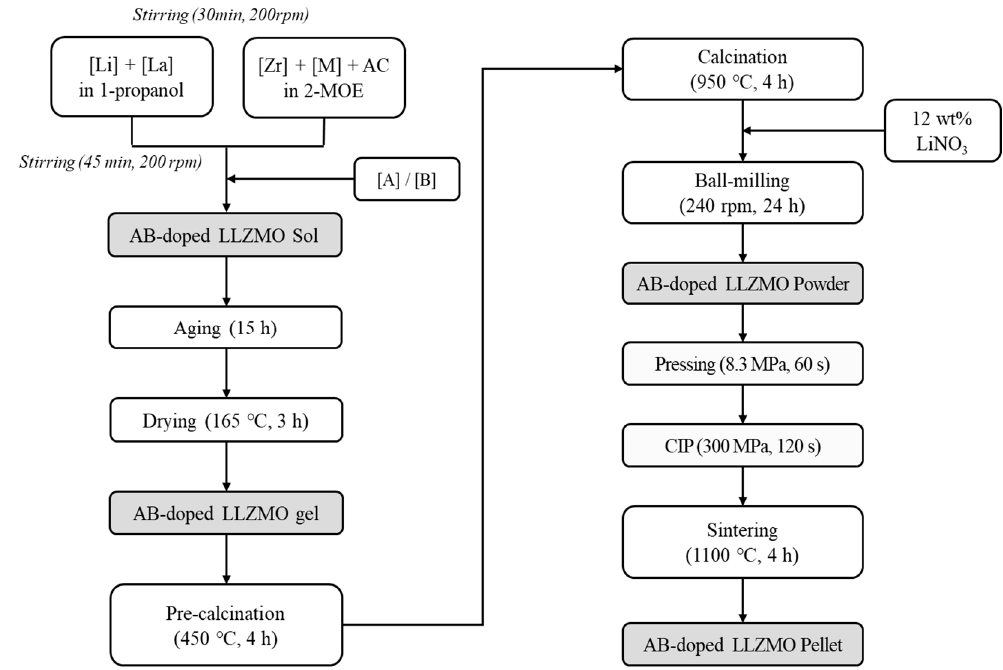
Figure 1. Optimized synthesis process of doped- Li 7 La 3 Zr 2 O 12 (LLZO) ceramics (AC: acetic acid solution; 2-MOE: 2-methoxyethanol; M: Zr 4+ site dopant; A: Li + site dopant; B: La 3+ site dopant; CIP: cold isostatic pressing; LLZMO: M-doped LLZO).